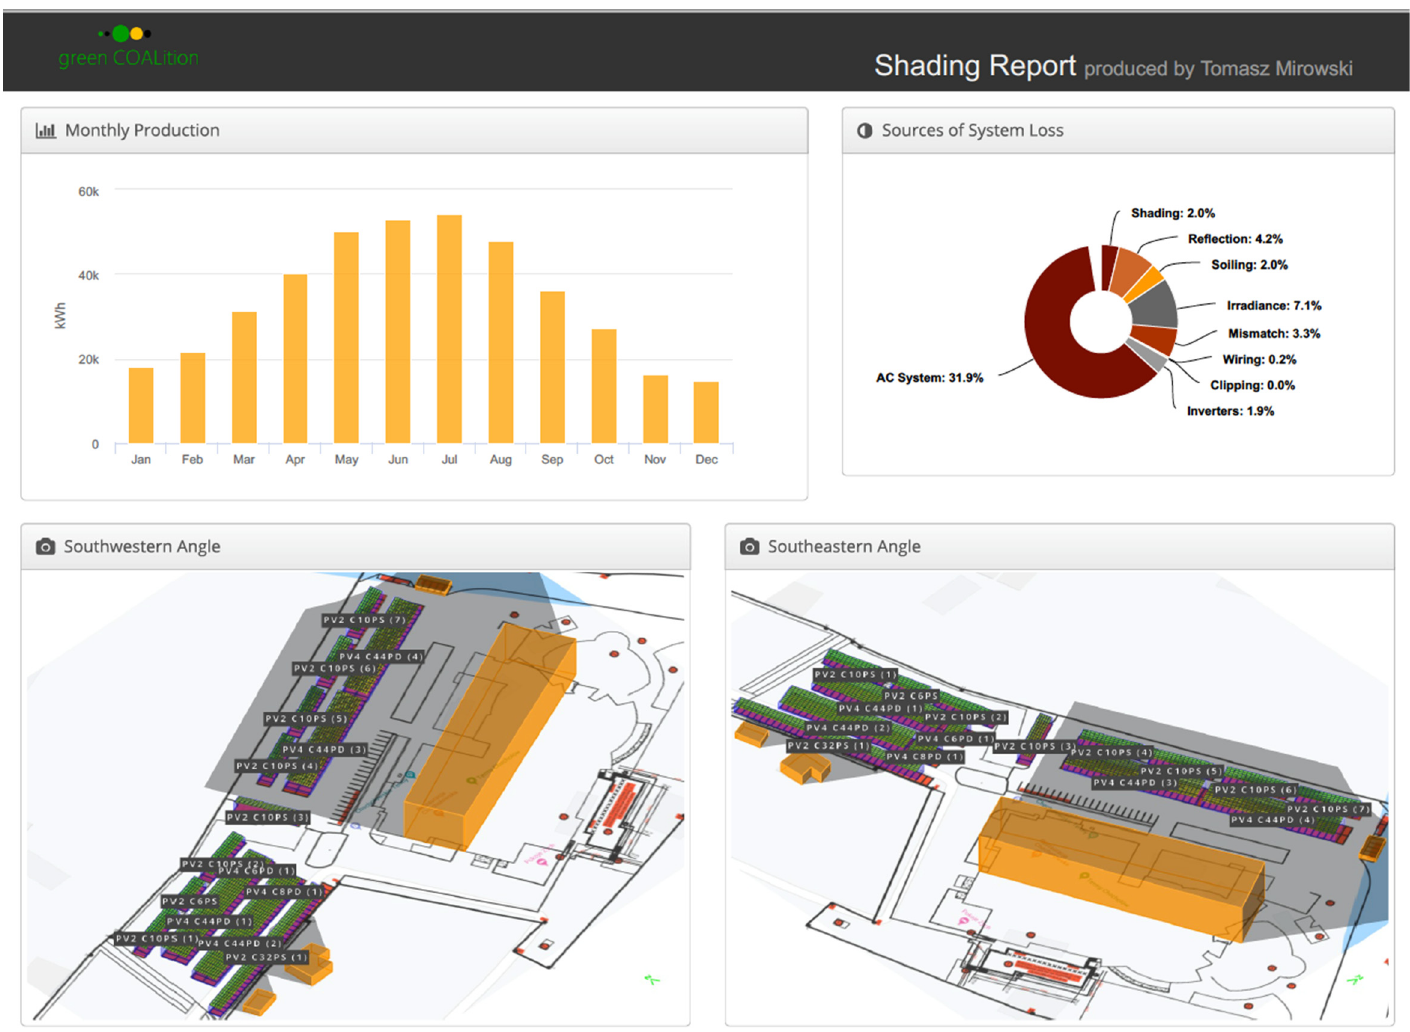
Figure 6. Shadow visualization; monthly energy yields and annual system losses, as visualized using HelioScope.